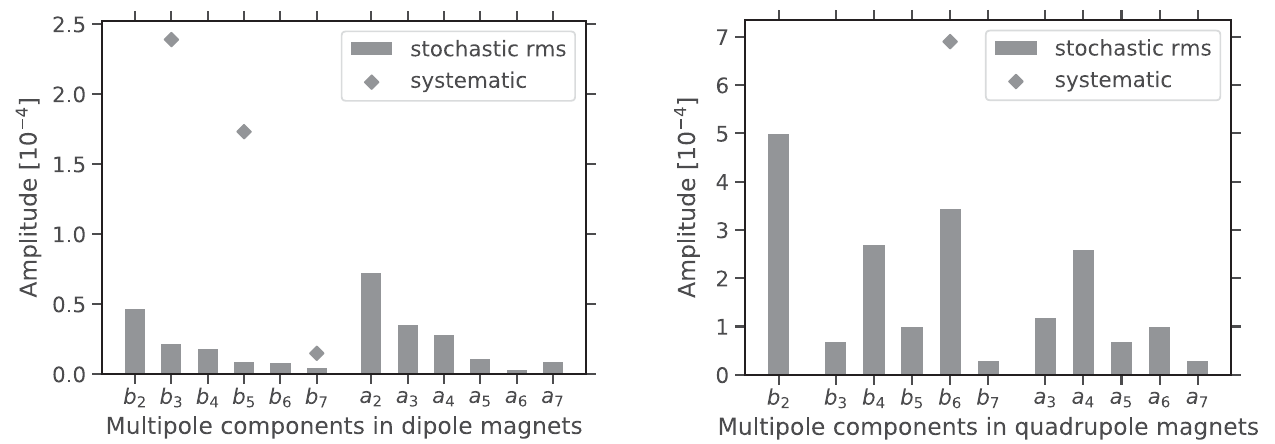
FIG. 21. Field error model based on cold bench